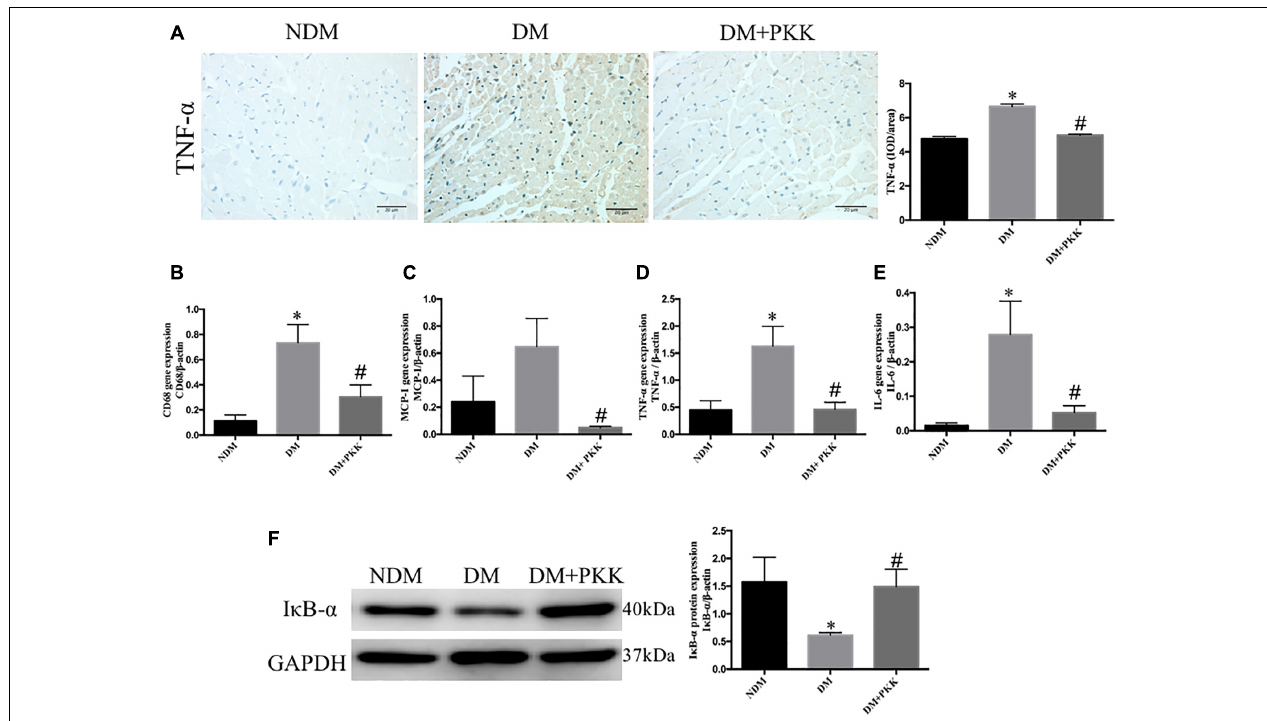
FIGURE 5 | Pancreatic kallikrein administration abolished myocardial inflammation in STZ-induced diabetic rats. (A) The IHC micrographs and quantitative data of myocardium tissue stained with TNF- α in the NDM, DM, DM + PKK groups (original magnification 40 × ). The mRNA expression of (B) CD68, (C) MCP-1, (D) TNF- α , and (E) IL-6. (F) The protein expression and quantitative data of I κ B- α . Each sample for qPCR and western blot was repeated for three times. Values are mean ± SEM, n = 6 per group; ∗ P < 0.05 vs. NDM group; # P < 0.05 vs. DM + PKK